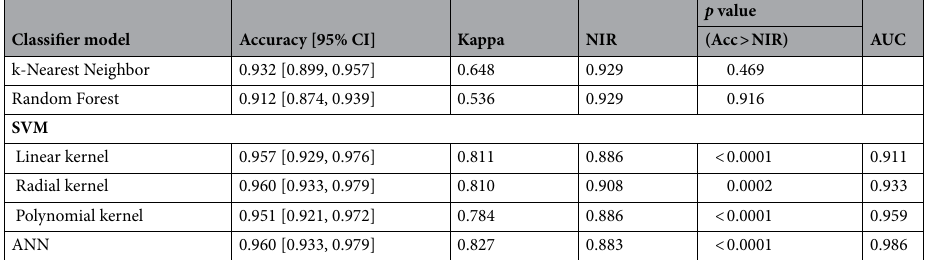
Table 4. Summary of performance metrics for all the machine learning classifiers under study. NIR no-information rate, Acc accuracy, AUC Area under the curve of the receiver operating characteristics, SVM Support vector machine, ANN Artificial neural network.